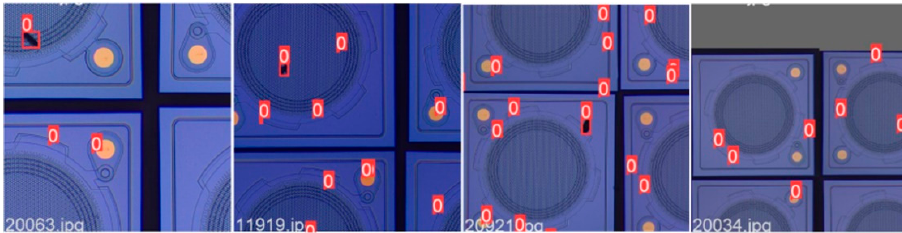
Figure 6. Mosaic data augmentation. (Red 0 represents single class label boxes.)